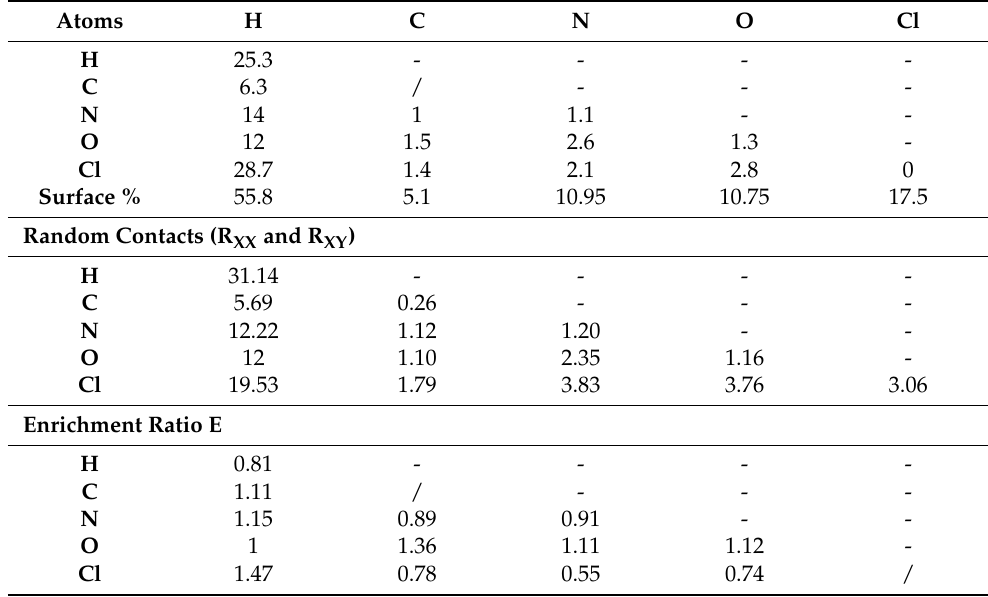
Table 3. Percentage contributions of interactions, surface contacts (S X ), random contacts (R XX /R XY ), and enrichment ratios (E XX /E XY ) for (C 2 H 7 N 4 O) 2 BiCl 5 .